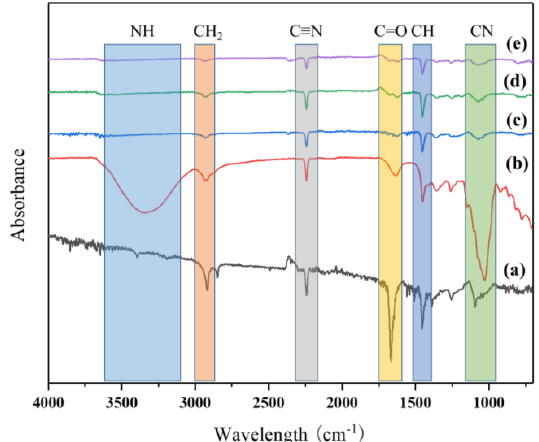
Figure 4. ATR Spectra of PAN nanofibers: ( a ), stabilized neat PAN nanofibers: ( b ), PAN/AgNPs nanofibers one cycle loaded: ( c ), PAN/AgNPs nanofibers two cycles loaded: ( d ), PAN/AgNPs nanofibers three cycles loaded: ( e ).